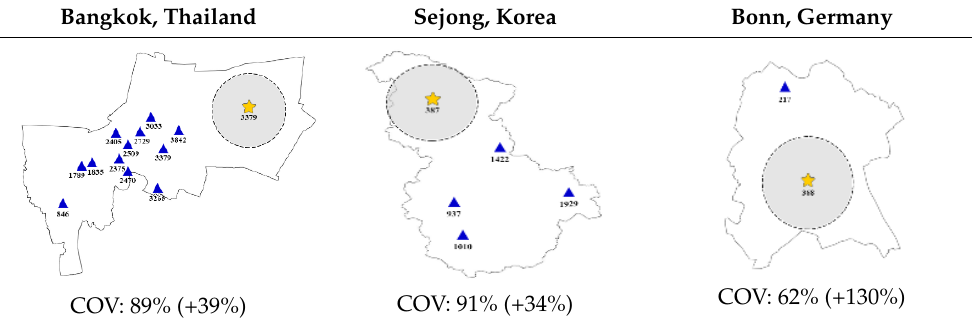
One of the key limitations of our study is the appropriate ratio of spatial coverage satisfaction versus confidence area. As shown in Figure 8, the dashed line plot graph com- pares coverage percentage and the number of stations. The 6th stations show the most coverage percentage of 90%. Increasing the number of stations from 7 up to 12 does not significantly increase coverage. Thus in future work, a change of strategy is needed after achieving the spatial coverage to increase the overlapped regions.